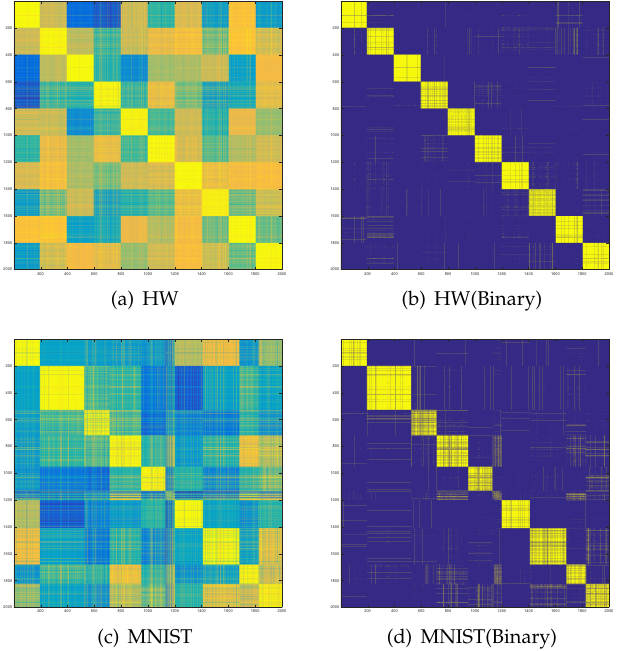
Figure 5. Block diagonal structure visualization of VV T . ( a , c ) are the original VV T of HW and MNIST, respectively. ( b , d ) are the binarized VV T of HW and MNIST,